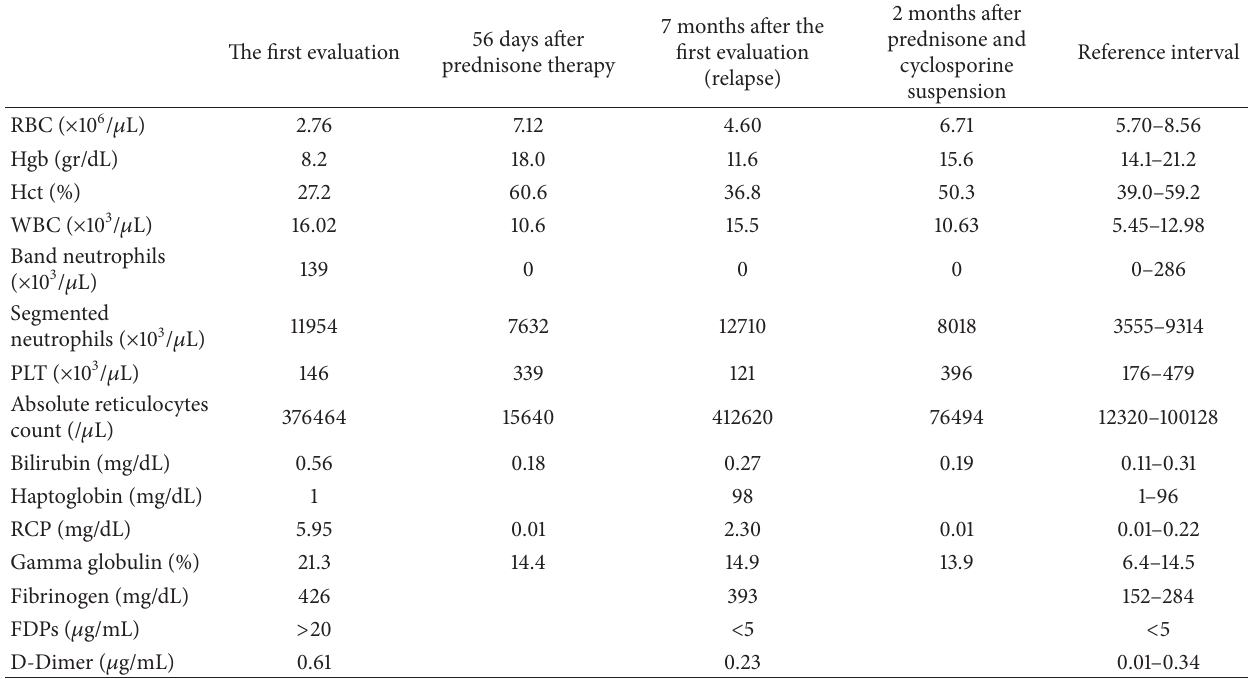
Table 1: Cell blood count, serum chemistry, serum protein electrophoresis, and hemostatic profile: the first clinical evaluation and follow-up. 56 days after The first evaluation prednisone